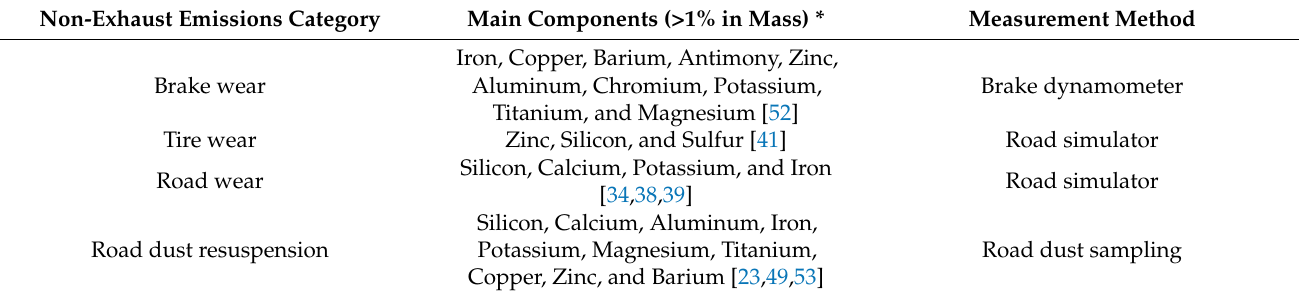
Table 1. Chemical composition of non-exhaust PM